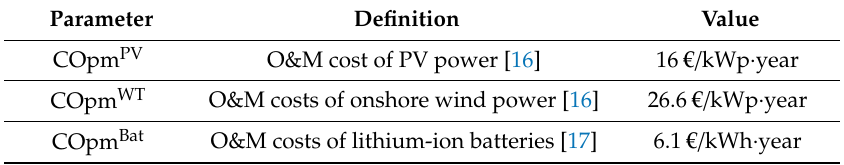
Table 6. Parameters related to energy costs.